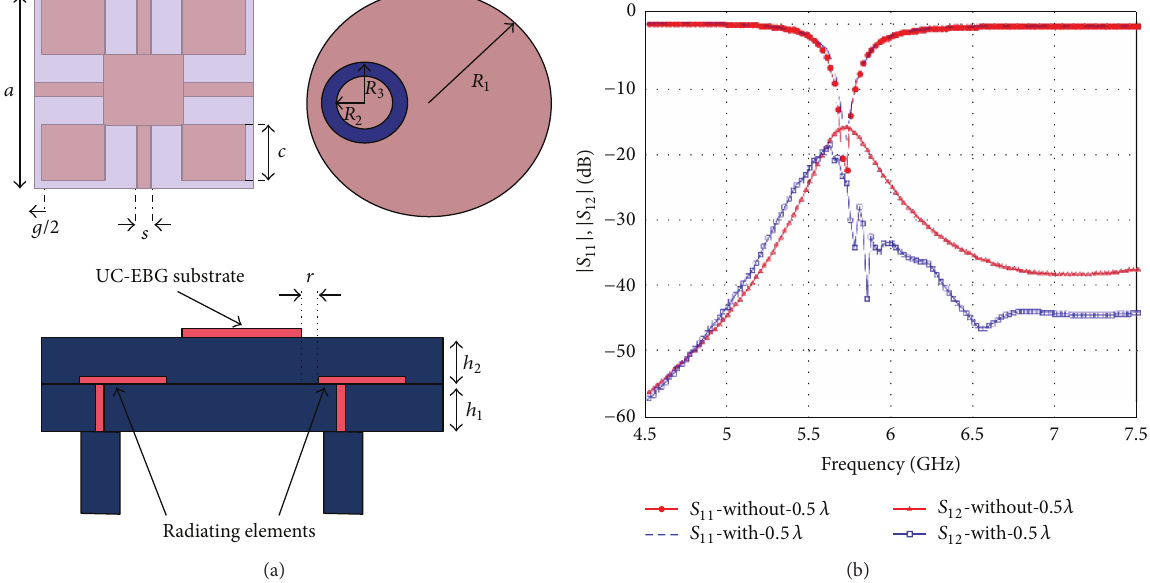
Figure 26: (a) UC-EBG structure on a multilayer configuration and circular microstrip antenna array. (b) 𝑆 -parameters of the array.